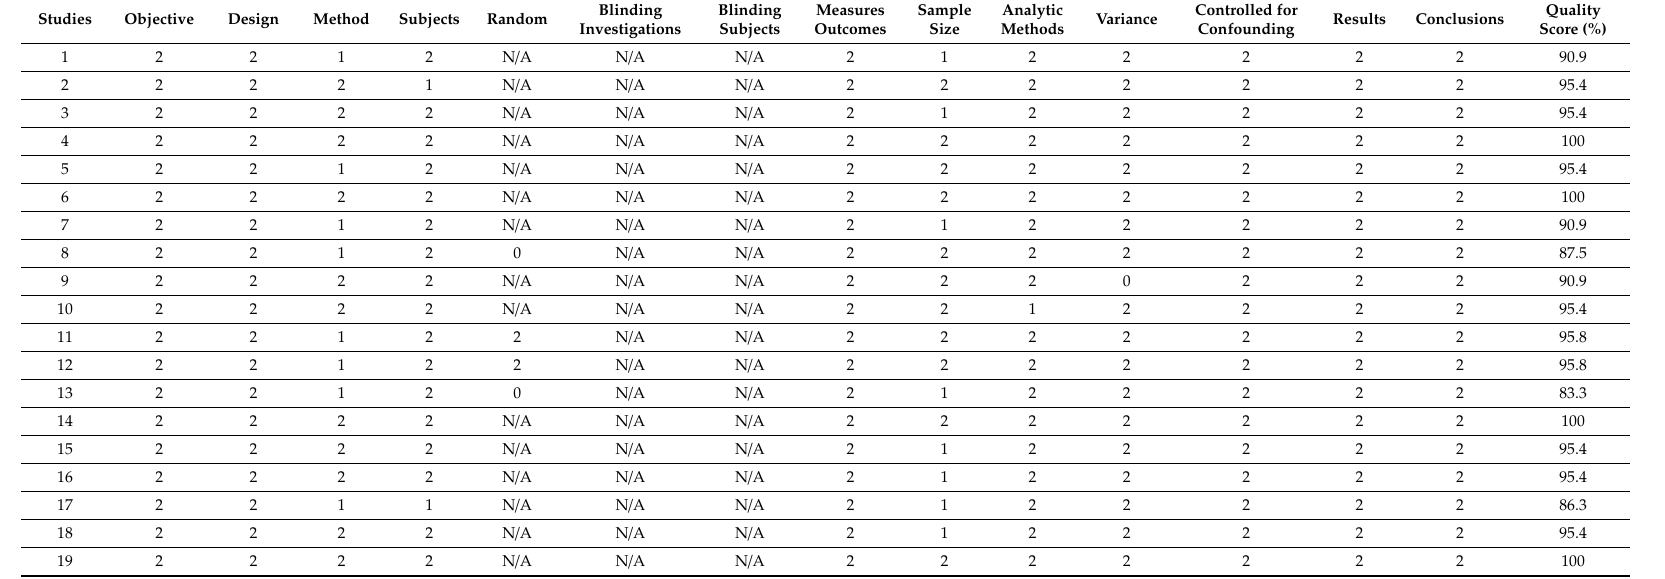
Table 2. Manuscripts Quality